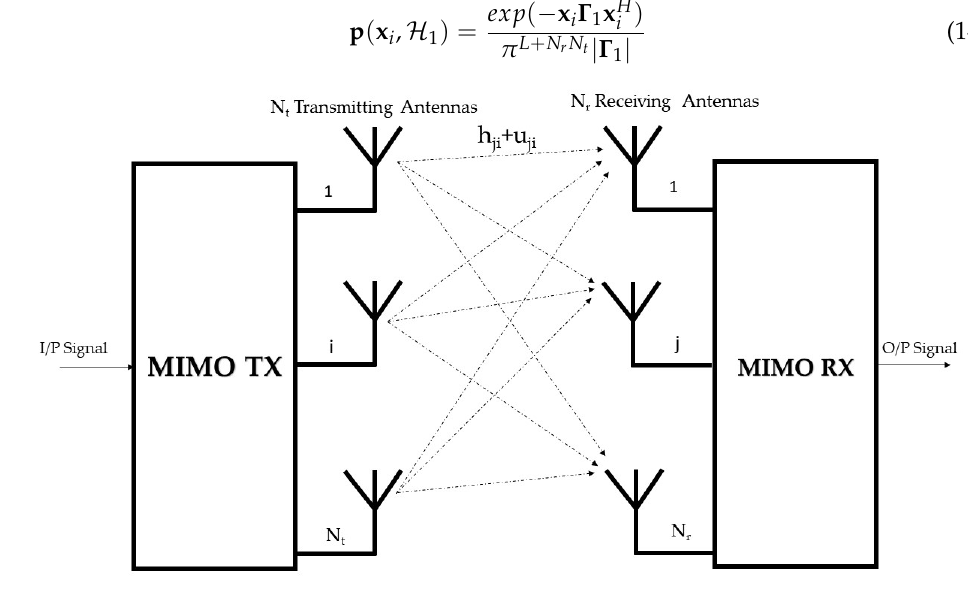
Figure 1. MIMO cognitive radio system model consisting of single PU with N t transmitting antennas and single secondary user with N r receiving antennas.